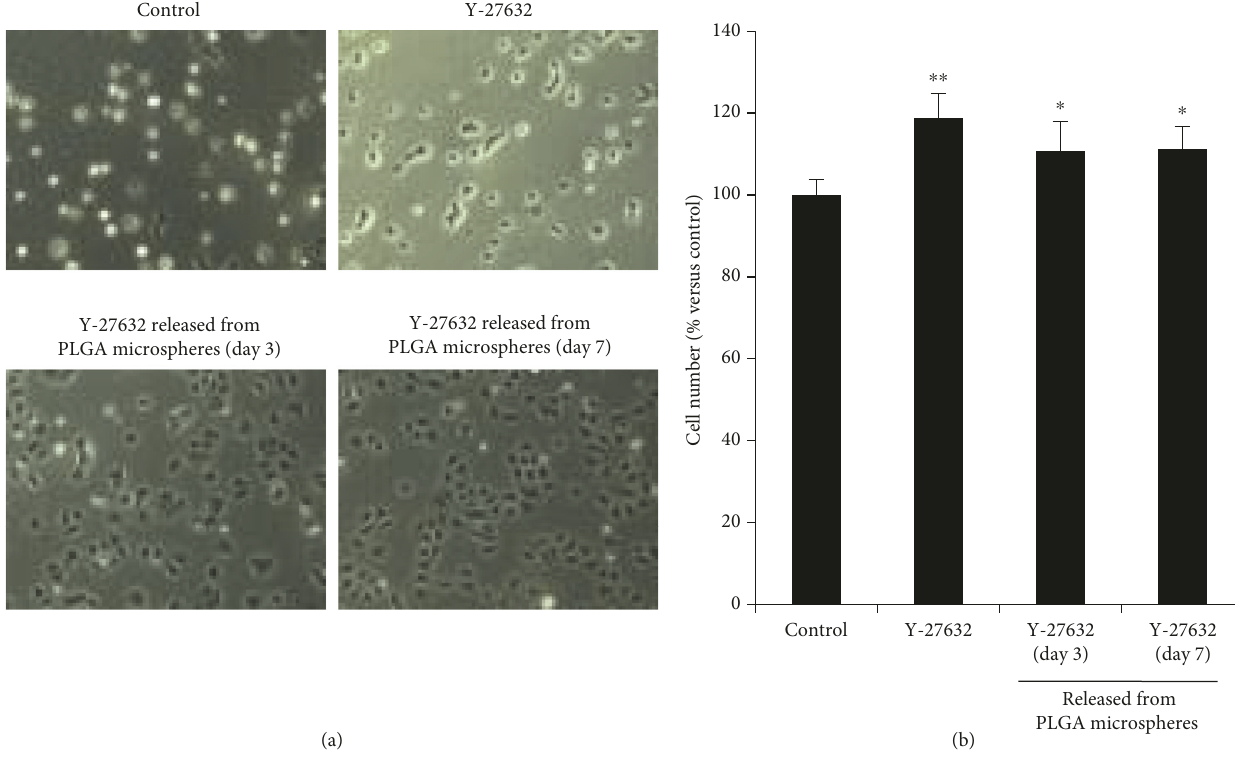
Figure 2: Stability and safety assessment of Y-27632 released from PLGA microspheres. (a) Y-27632 incorporating poly lactic/glycolic acid (PLGA) microspheres was incubated in PBS, and PBS was recovered after 3 and 7 days. The amount of Y-27632 released in the PBS was added to a culture medium as fi nal concentration of Y-27632 as 10 μ M. Phase contrast images of corneal endothelial cells (CECs) cultured for 24 hours are shown. (b) CECs were seeded at a density of 5.0 × 10 3 cells/cm 2 per well on a 96-well plate for 24 hours and subjected to serum starvation for an additional 24 hours supplemented with fresh Y-27632 (10 μ M) or Y-27632 released from PLGA microspheres after 3 or 7 days (10 μ M). Control cells were CECs cultured for an additional 24 hours without supplementation with Y-27632. The data represent average ± SE ( n = 5 ). ∗∗ p < 0 01 , ∗ p < 0 05 . These experiments were performed in